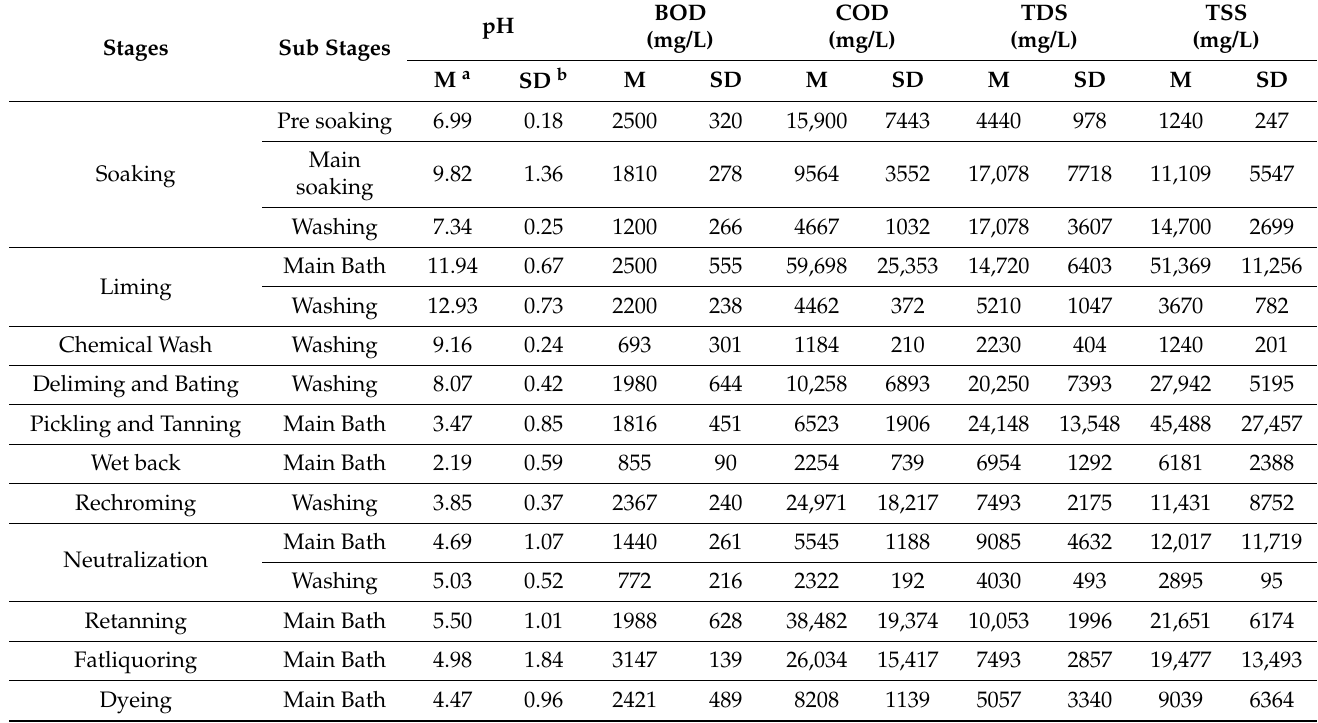
Table 3. Physiochemical characteristics of effluent in each stage of leather processing.